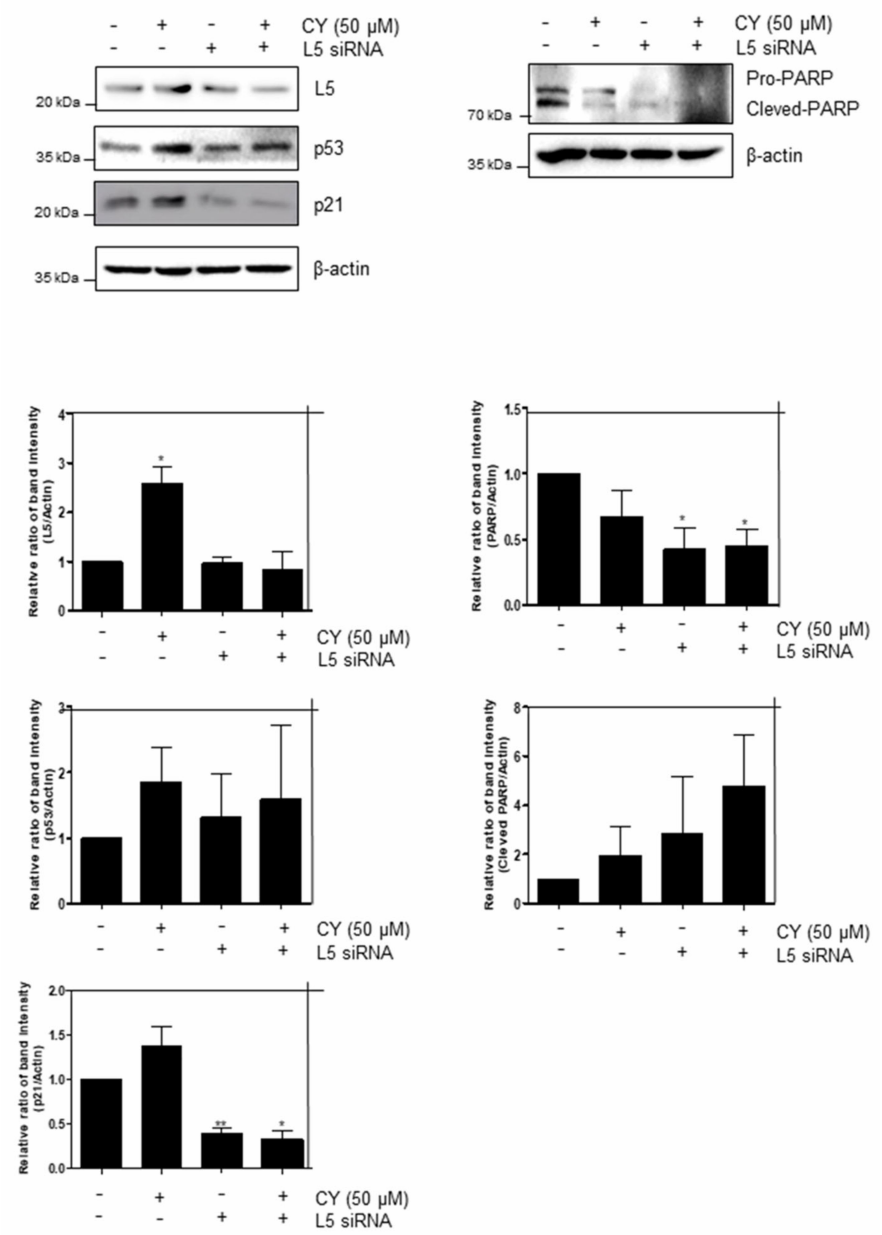
Figure 7. RPL5 mediates p53-dependent apoptosis in CY-treated HCT116 p53+/+ cells. Effect of RPL5 depletion on p53, p21 and RPL5 in HCT116 p53+/+ cells. HCT116 p53+/+ cells were transfected with control or L5 siRNA plasmids for 48 h, exposed to CY (50 µ M) for 24 h, followed by Western blotting with antibodies of p53, p21, Pro-PARP, RPL5 and β -actin carried out. Ratio of each protein was determined by ImageJ. * p < 0.05. ** p <